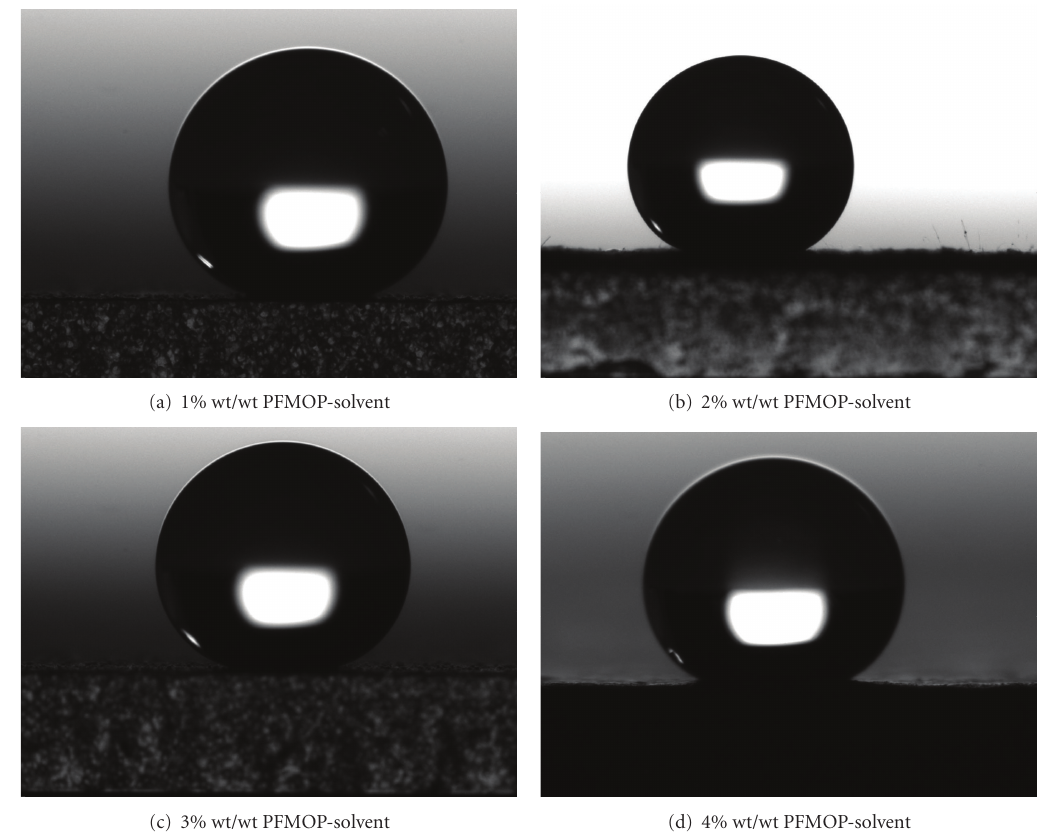
Figure 7: Photos of water drops on electrospun fiber mat surfaces from di ff erent polymer-solvent solution concentrations.